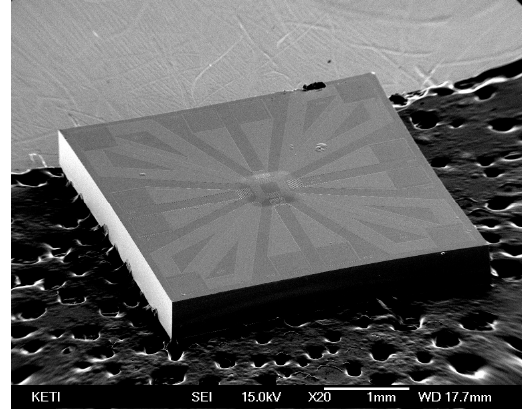
Figure 3. Appearance of the manufactured MEMS 2D wind direction and wind speed sensor chips.